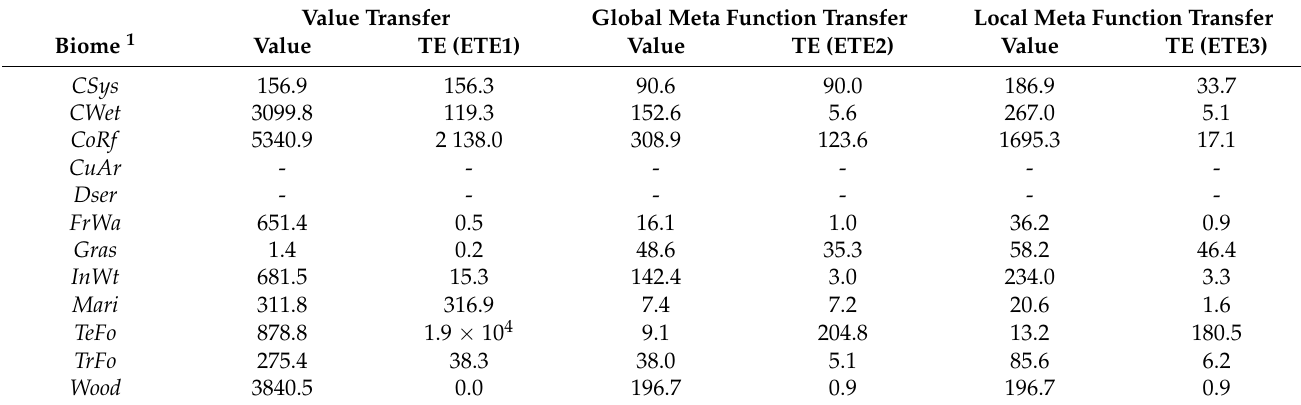
Table 8. Comparison of values and transfer errors (TE) per biome for Cultural ES, based on Value transfer, Global meta function transfer, and Local meta function transfer (in 2015 €